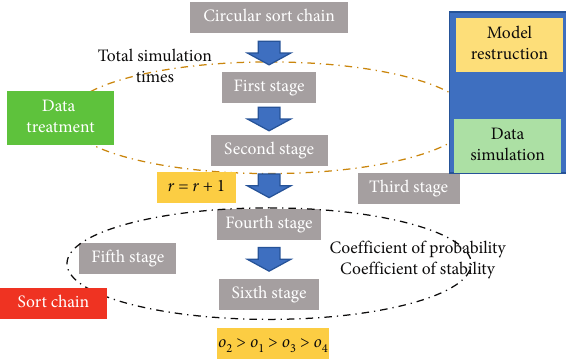
Figure 3: Circular sorting